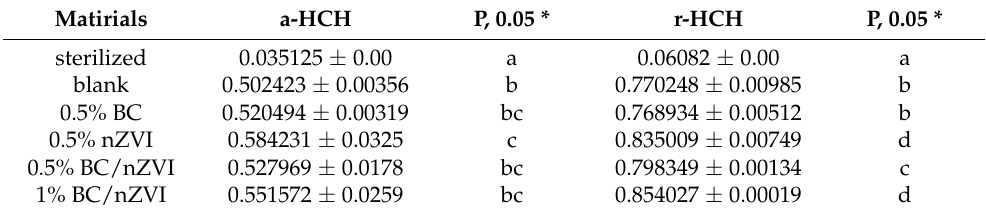
Table 2. Multiple comparison of degradation rates on α -HCH and γ -HCH by different materials. Matirials a-HCH P, 0.05 * r-HCH P, 0.05 * sterilized 0.035125 ± 0.00 a 0.06082 ± 0.00 a blank 0.502423 ± 0.00356 b 0.770248 ± 0.00985 b 0.5% BC 0.520494 ± 0.00319 bc 0.768934 ± 0.00512 b 0.5% nZVI 0.584231 ± 0.0325 c 0.835009 ± 0.00749 d 0.5% BC/nZVI 0.527969 ± 0.0178 bc 0.798349 ± 0.00134 c 1% BC/nZVI 0.551572 ± 0.0259 bc 0.854027 ± 0.00019 d *: Same letters indicate non-significant difference; different letters indicate significant